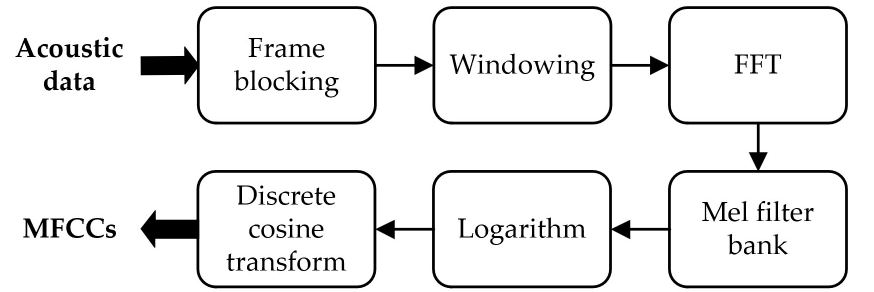
Figure 7. Steps of MFCCs feature extraction.